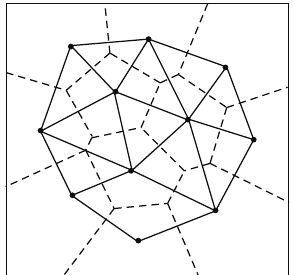
Figure 7: A Voronoi diagram (dashed) and its straight line dual, the Delaunay